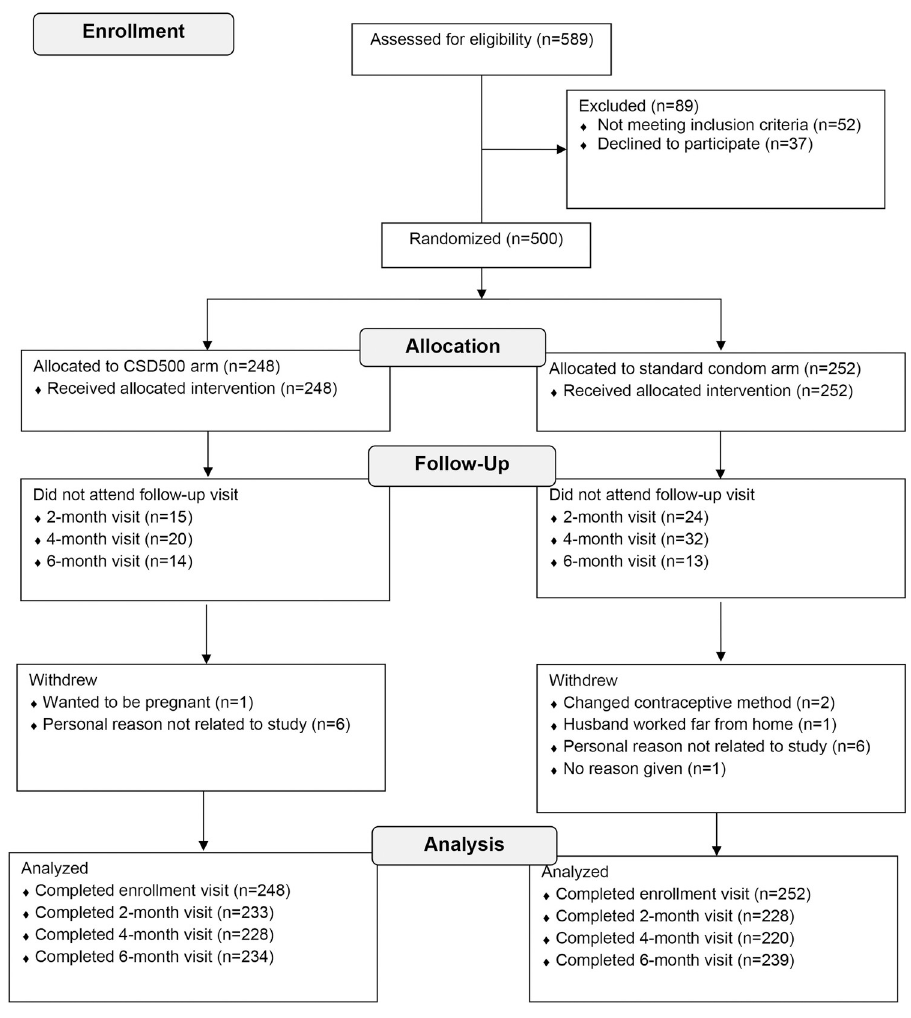
Fig 1. Disposition of potential